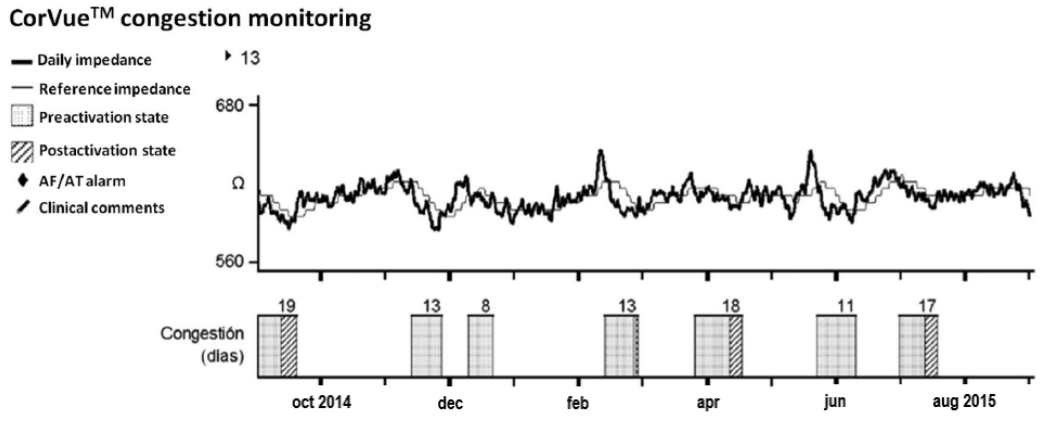
Figure 3. Trend of the CorVue TM congestion monitoring. This example illustrates the potentially misleading information displayed on the device follow-up report. The graphic shows seven episodes of congestion with different days of duration (pre-activation state: checked bars) that generated alarms (post-activation state: oblique lined bars) for four of these episodes without an associated clinical event (false positive). Reproduced with permission from Palfy et al. (Pacing Clin Electrophysiol, 2018) [14].